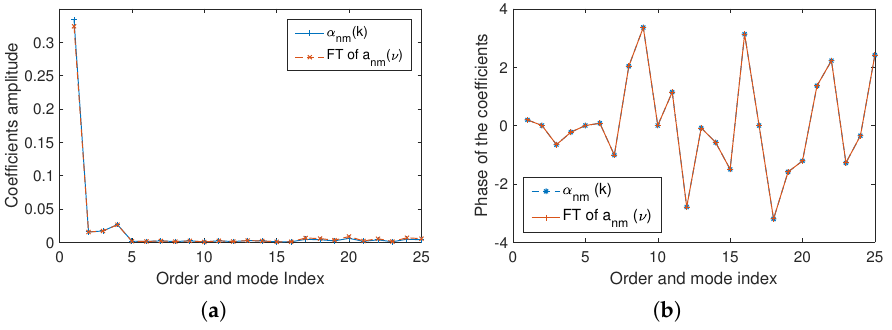
Figure 5. ( a ) Amplitude and ( b ) phase difference comparison between the Fourier Transform of the time domain spherical harmonic coefficients a nm ( ν ) and frequency domain spherical harmonic coefficients α nm ( k ) at a single frequency f = 1200 Hz.